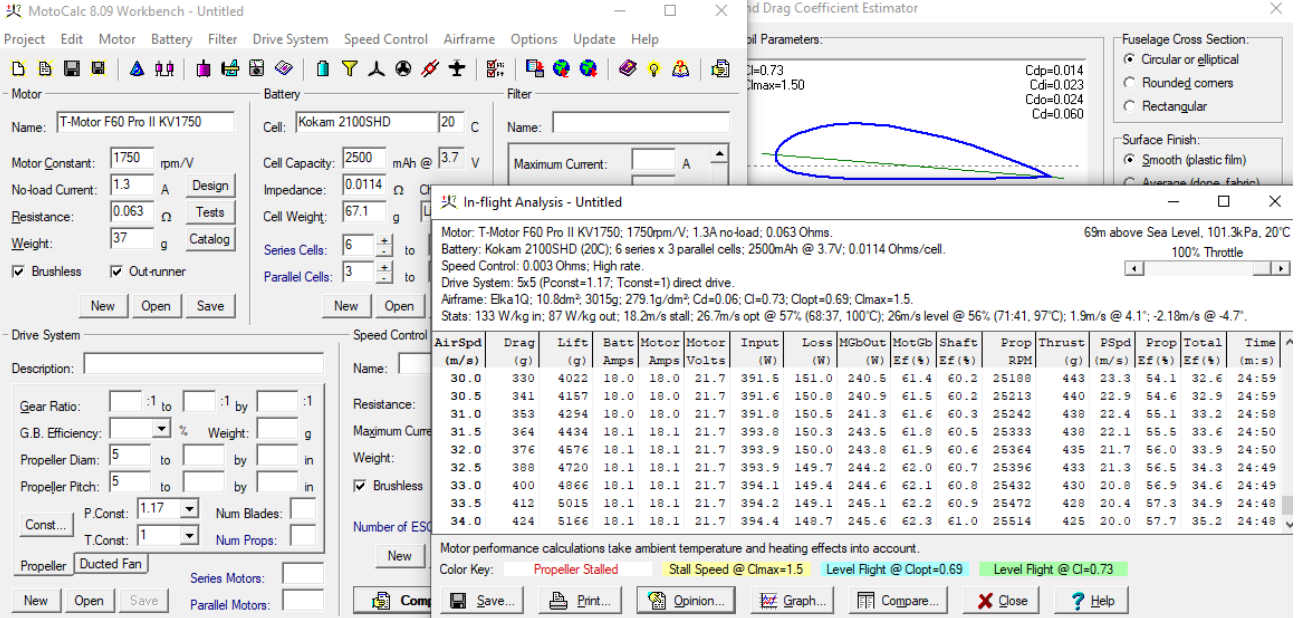
Figure 7. The MotoCalc 8.09 [31] workbench; the tool helped us estimate the drone performance in level flight (plane mode).